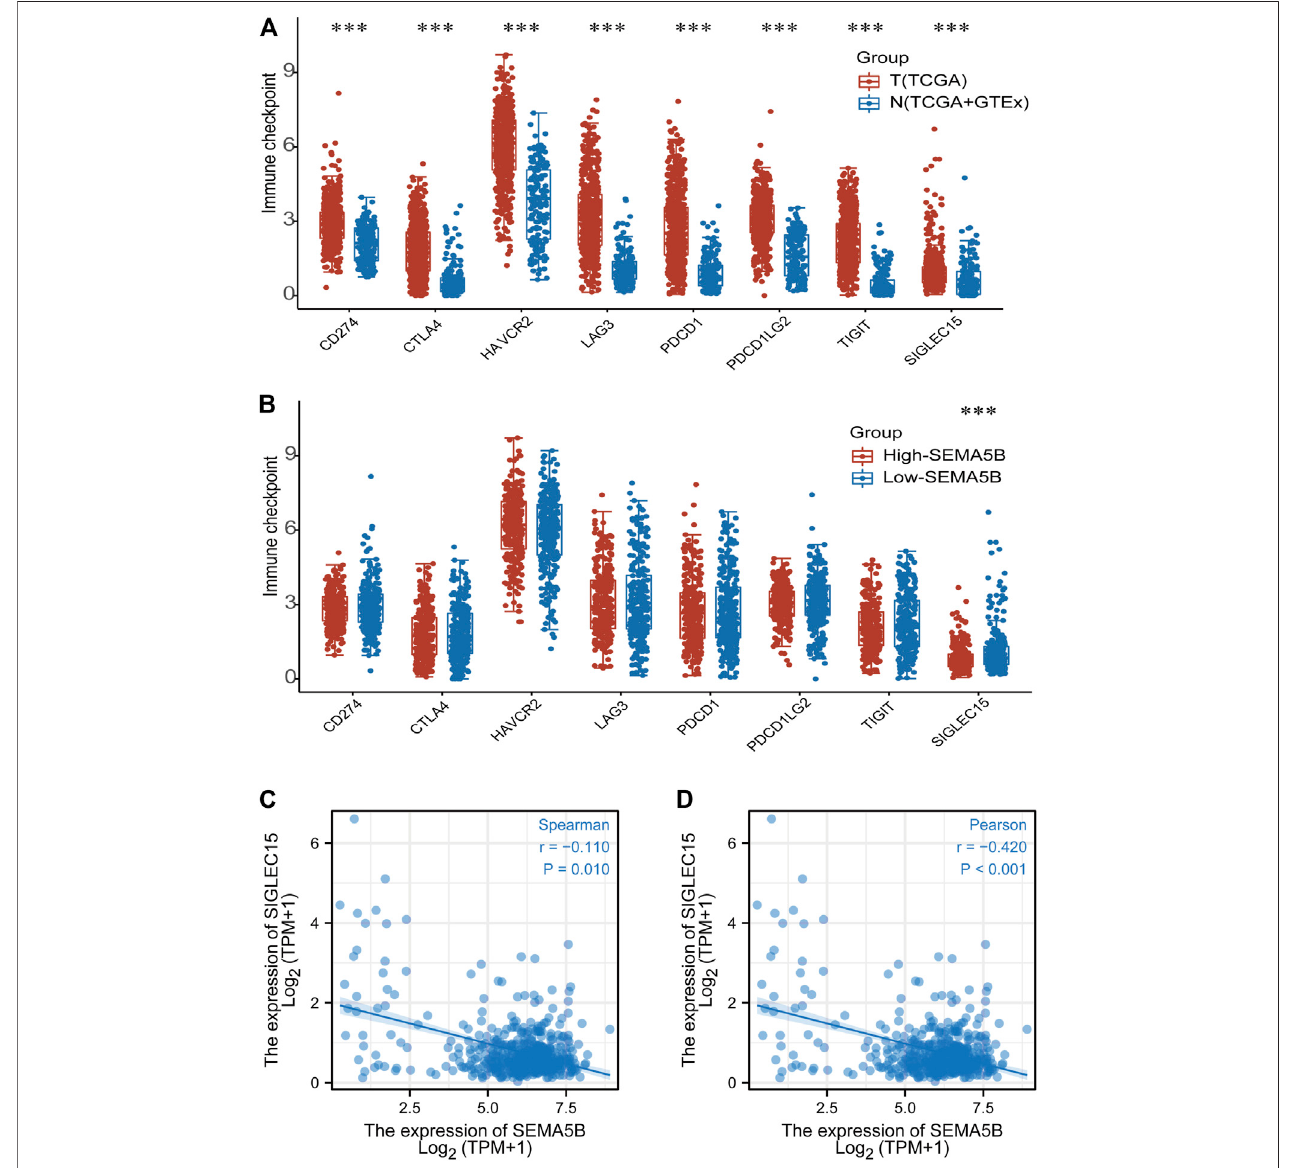
FIGURE 7 | Immune checkpoint gene analysis. (A) The expression distribution of checkpoint genes in tumor tissues and normal tissues. (B) Expression of checkpointgenesinhigh-andlow-SEMA5Bexpressiongroups.Spearmancorrelation (C) andPearsoncorrelation (D) fortherelationshipbetweentheexpressionlevels of SEMA5B and SIGLEC15. *** p <